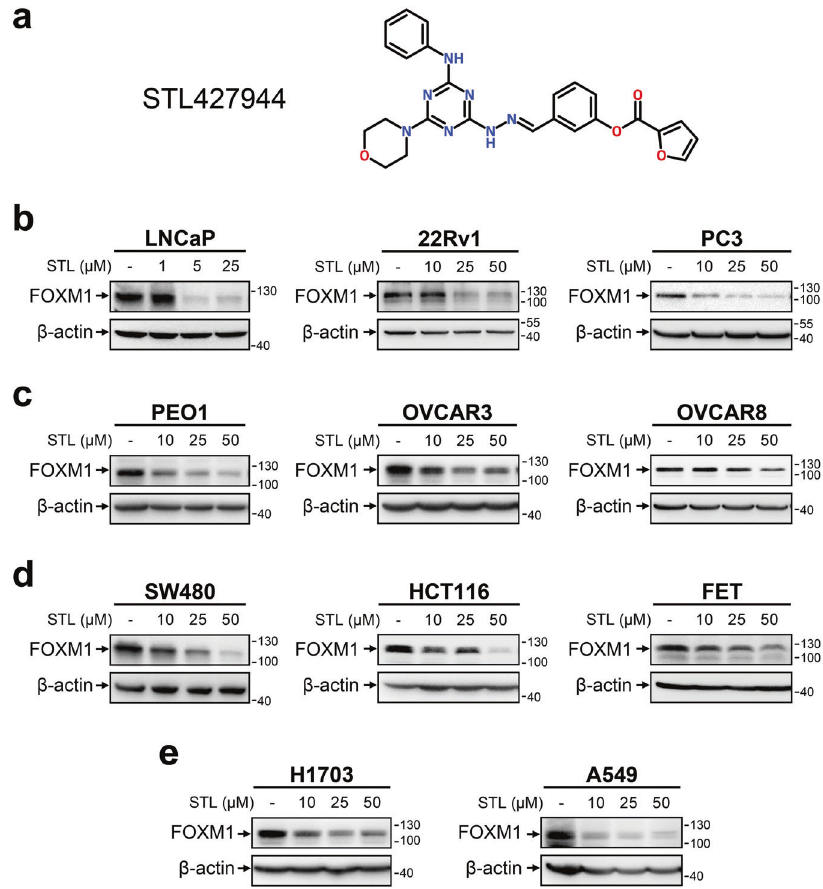
increasing concentrations of STL for 24 h. Total protein samples obtained from treated cells were analyzed for FOXM1 protein levels via immunoblotting, β -actin was used as internal loading